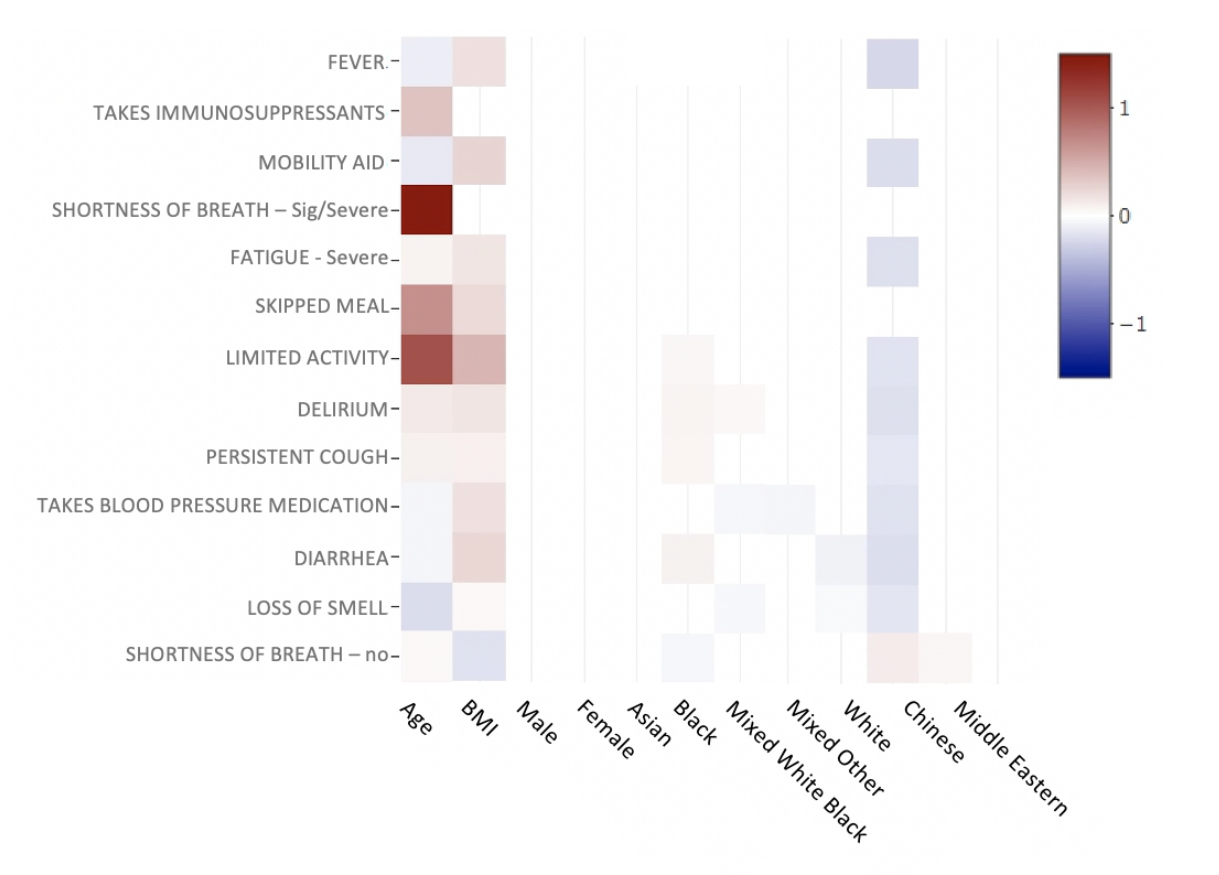
Figure 5. Multivariate logistic regression where each Elastic Net regression–selected feature is regressed onto demographic information such as age, BMI, gender, and race. Coefficients are plotted in a heat map. Only statistically significant associations are plotted. Age has a significant but weak association with many selected features. Users who identified as Black in the United Kingdom have many positive associations with high coefficients. Sig: